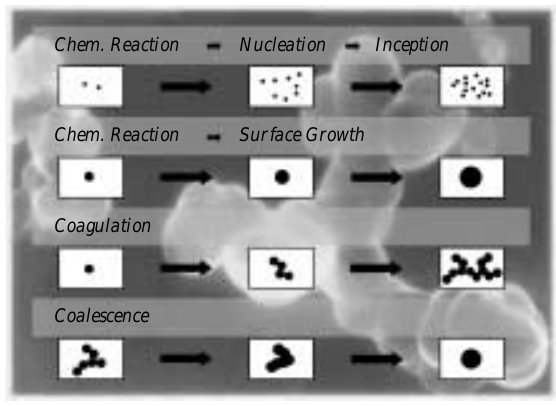
Formation mechanisms relevant in gas-phase synthesis of particles.